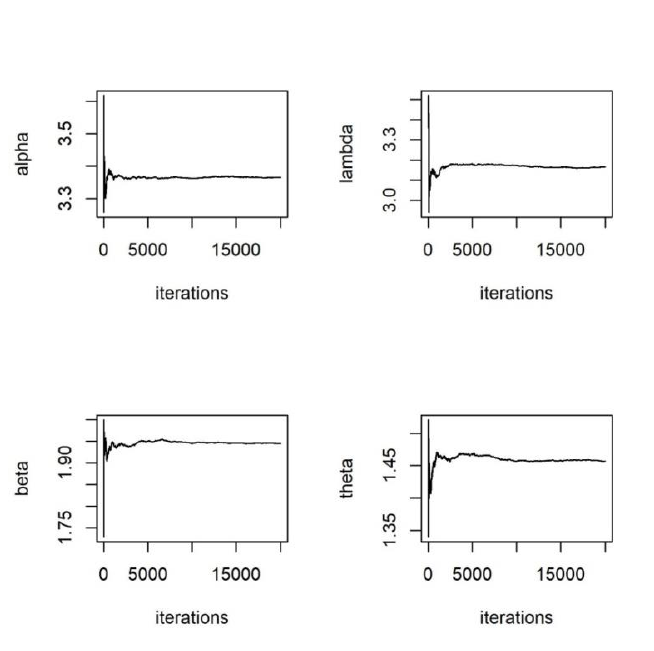
Figure 2. Cumulative mean plots for 𝛼, 𝜆, 𝛽, 𝜃 .